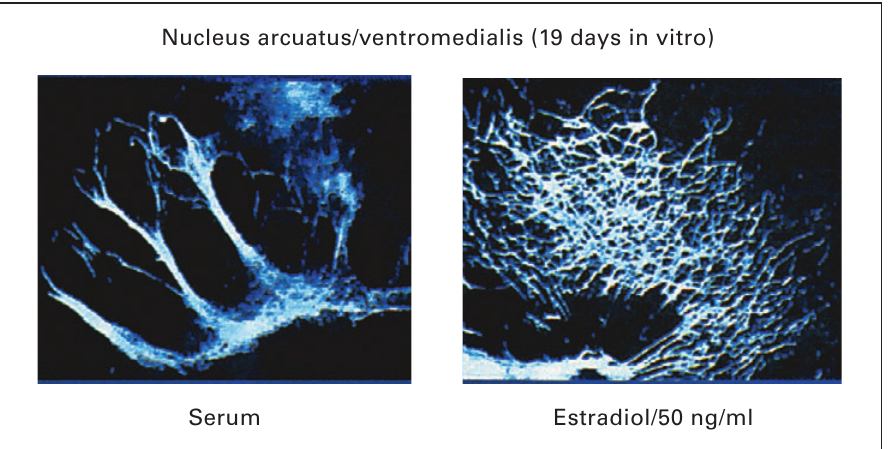
Figure 2 Neuritic proliferation in response to estra- diol. (Explant of organotypic cultures from newborn